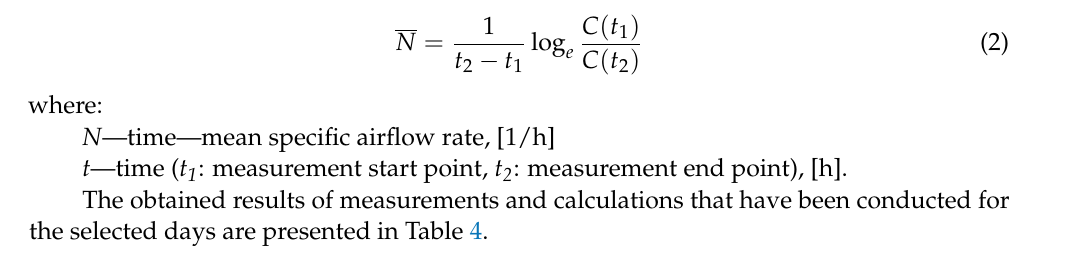
Figure 10. CO 2 concentration decay curve–23 January 2021. The specific airflow rates were calculated separately for three representative days by means of a two-point decay method, Equation (2).